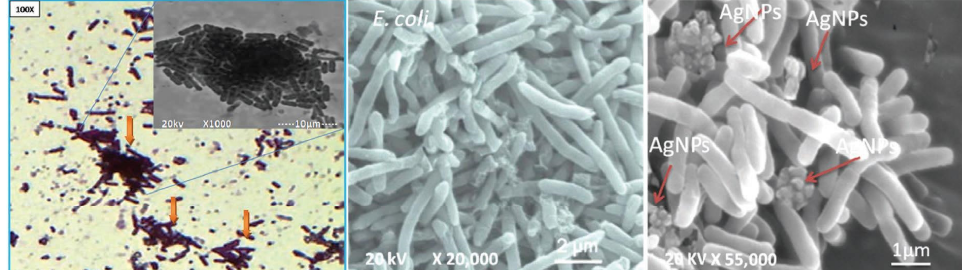
Figure 7: Bioflm formation of E . coli bacteria under broth condition. SEM images of E . coli with